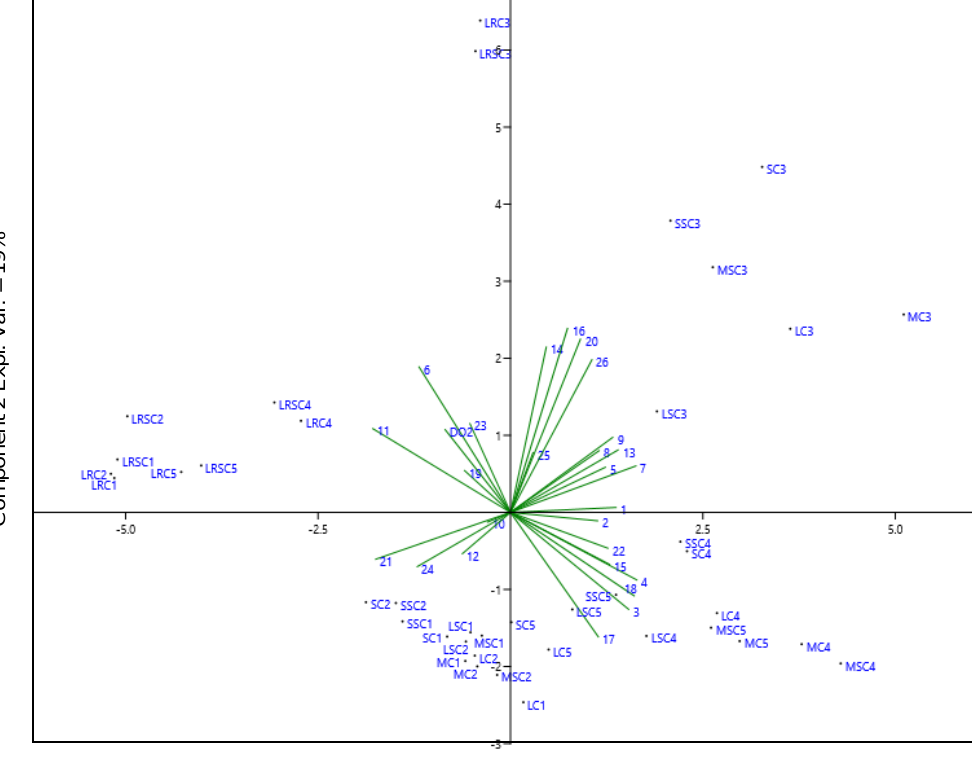
Figure 2. PCA bi-plot (PC-1 29%, PC-2 19%) of the three red wines and the rosé wine closed with different stoppers considering the volatile profiles and the dissolved oxygen (DO 2 ) during 12 months of bottle storage. Samples: LRC, LRSC, Lagrein rosé closed with conventional or ’blend’ stopper, respectively. SC and SSC, St. Magdalener with conventional or ‘blend’ stopper. LC, LSC, same for Lagrein. MC, MSC, Merlot. Storage in bottle: 1 , wine just after bottling; 2 , 3 , 4 , 5 , wine analyzed one, three, six and 12 months after bottling, respectively. Volatile compounds are named 1 – 26 as listed in Table 4.